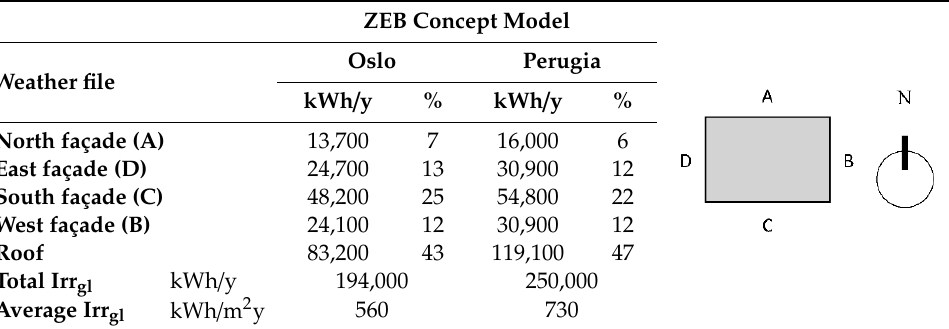
Table 7. Results of the solar analyses conducted during Step 1 on the ZEB concept model.